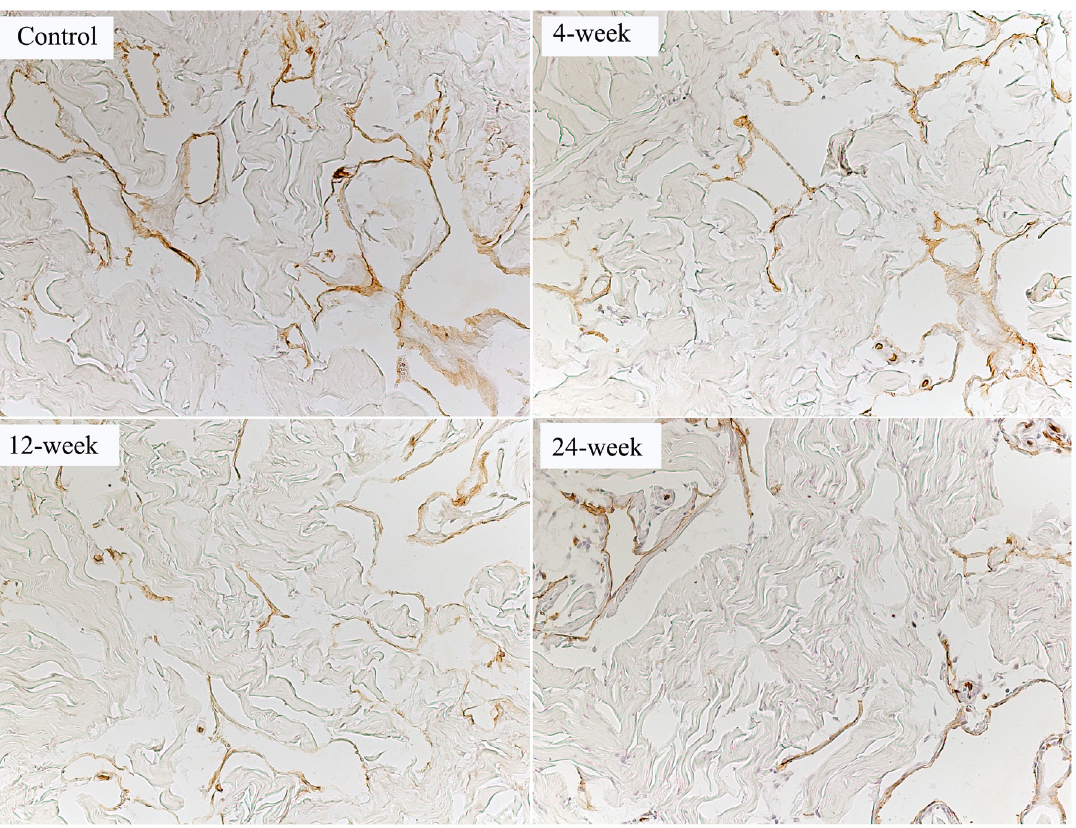
Fig 3. Endothelium content in the corpus cavernosum. Representative images from rats in the control, 4-week, 12-week and 24-week groups. Endothelial cells are stained brown with the rat endothelial cell antigen-1 (RECA-1) antibody. The intense positivity of RECA-1 was higher in control than in 12-week and 24-week groups. Magnification is x200.